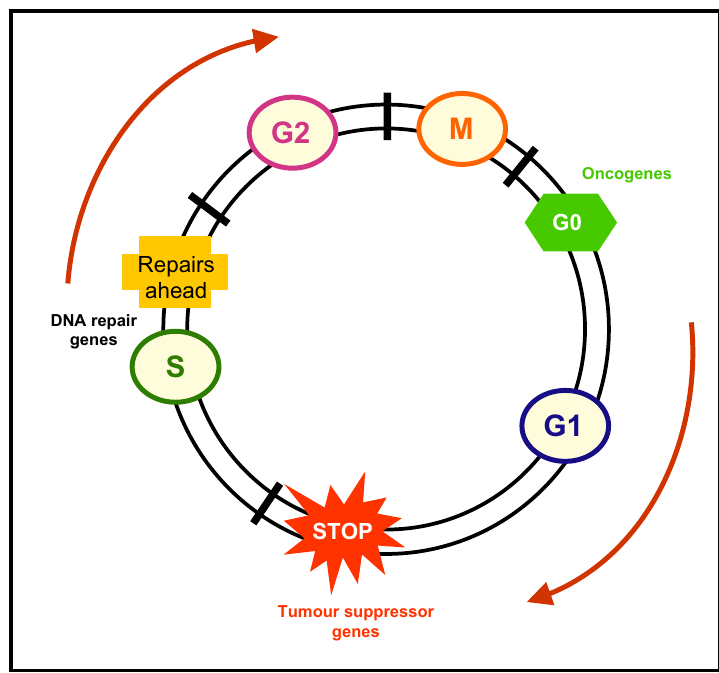
Fig. 6 – Cell cycle and its control by molecular targets (oncogenes and tumour suppressor genes). The cell cycle is a critical process that a cell undergoes in order to copy itself exactly. Most cancers cause mutations in the signals that regulate a cell’s cycle of growth and division, namely in oncogenes (which act as dominant mutations) and tumour suppressor genes (that function recessively). Normal cell division is required for the generation of new cells during development and for the replacement of old cells as they die. In normal cells, tumour suppressor genes act as braking signals during G1 to stop or slow the cell cycle before it reaches the S phase. DNA repair genes are active throughout the cell cycle, particularly during G2 after DNA replication and before the chromosomes prepare for